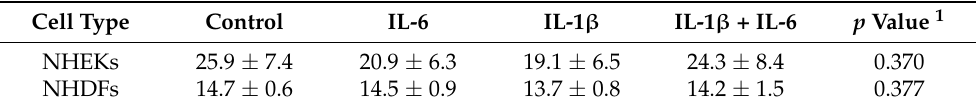
Table 1. LDH activity (mU/mL) in media from treated NHEKs and NHDFs.